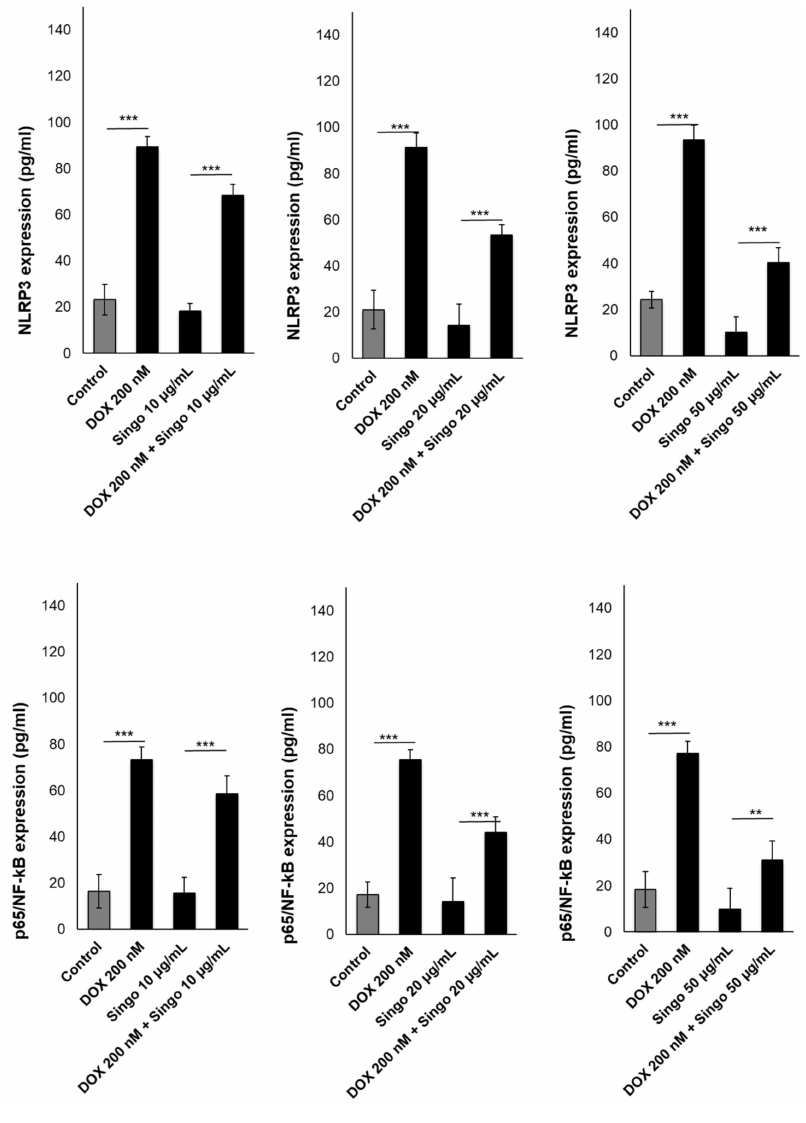
Figure 12. NLRP-3 inflammasome (upper panels) or p65/NF-kB (lower panels) expressed as pg/mL were quantified in human cardiac cells unexposed (control) or exposed to DOXO (200 nM), Singo (10, 25 and 50 µ g/mL) or both in combination for 24 h. Results: mean +/ − SD. *** p < 0.001. ** p < 0.01.